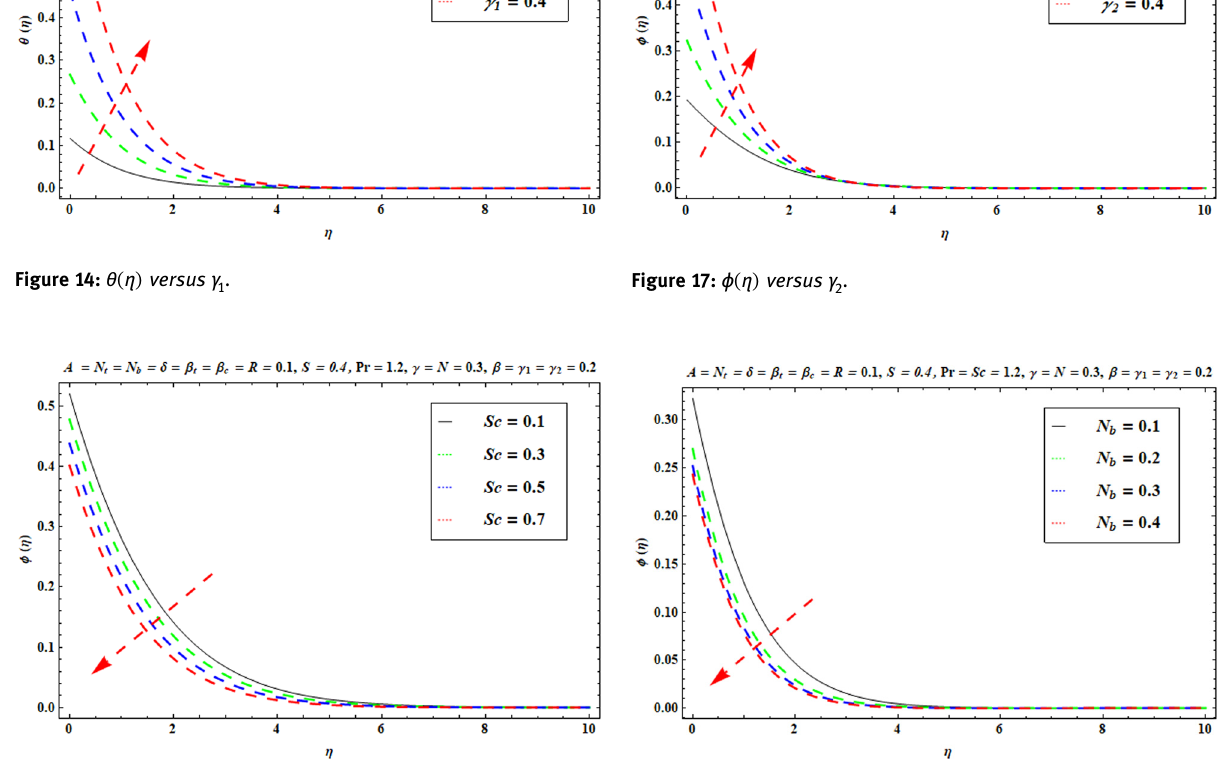
Figure 18: ϕ η ( ) versus N .